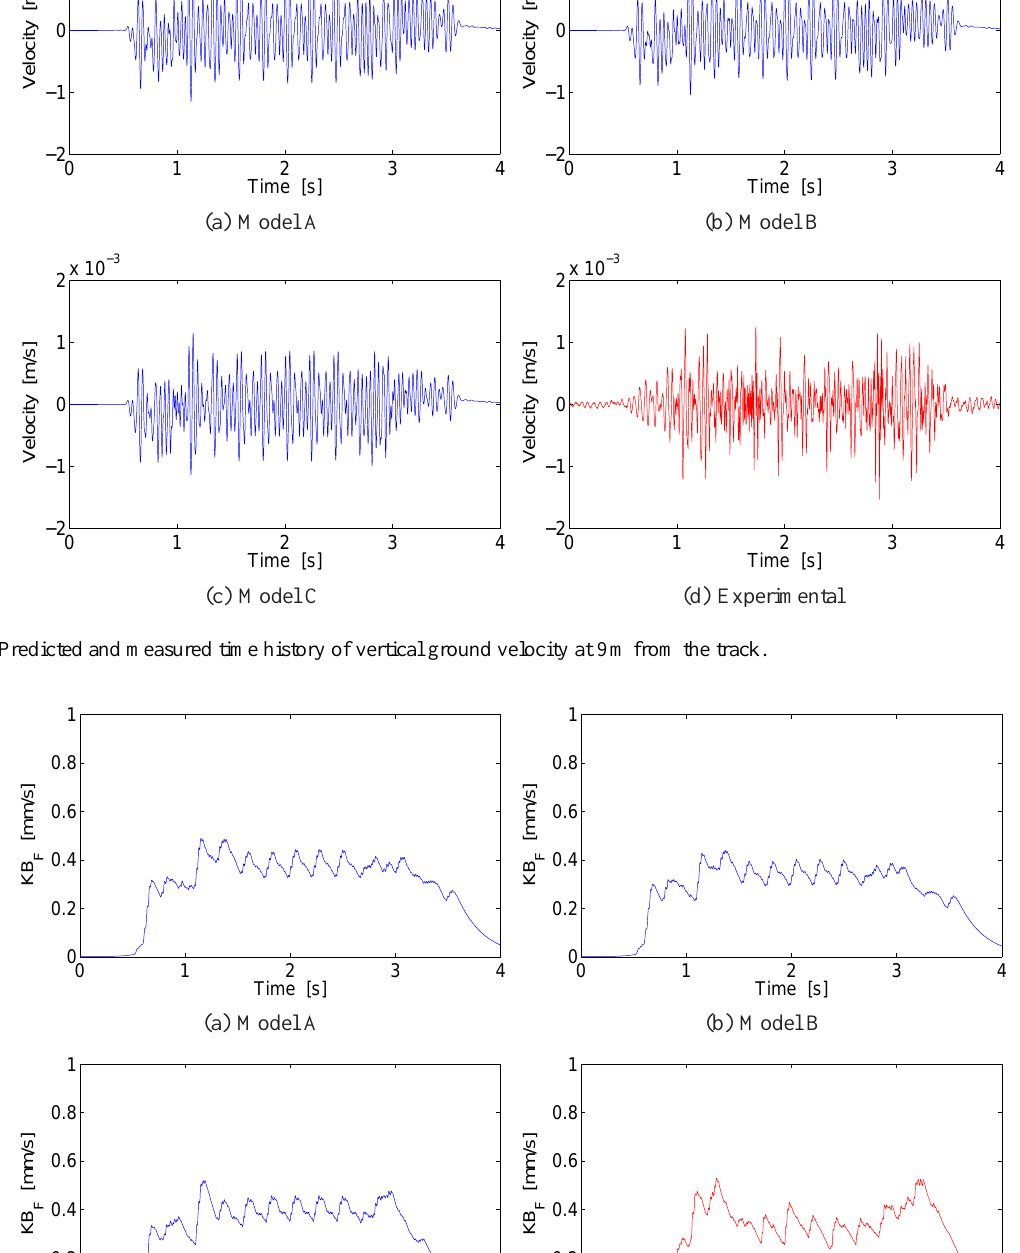
Mech. Sci. Mech. Sci.